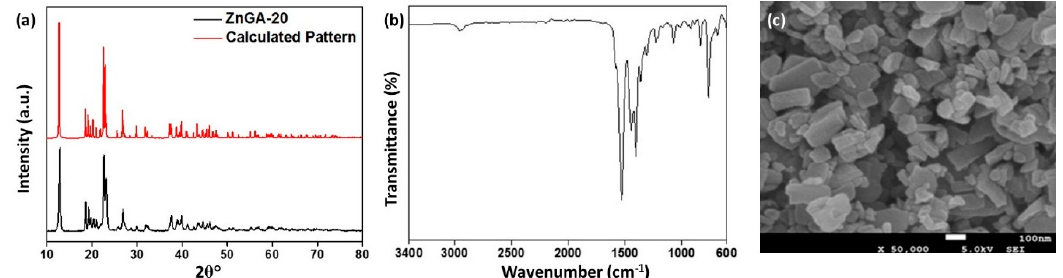
Figure 1. ( a ) PXRD pattern of ZnGA-20 and PXRD pattern calculated from the crystal structure of ZnGA via Mercury 3.7 [57], ( b ) FT-IR spectrum, and ( c ) SEM image of ZnGA-20.